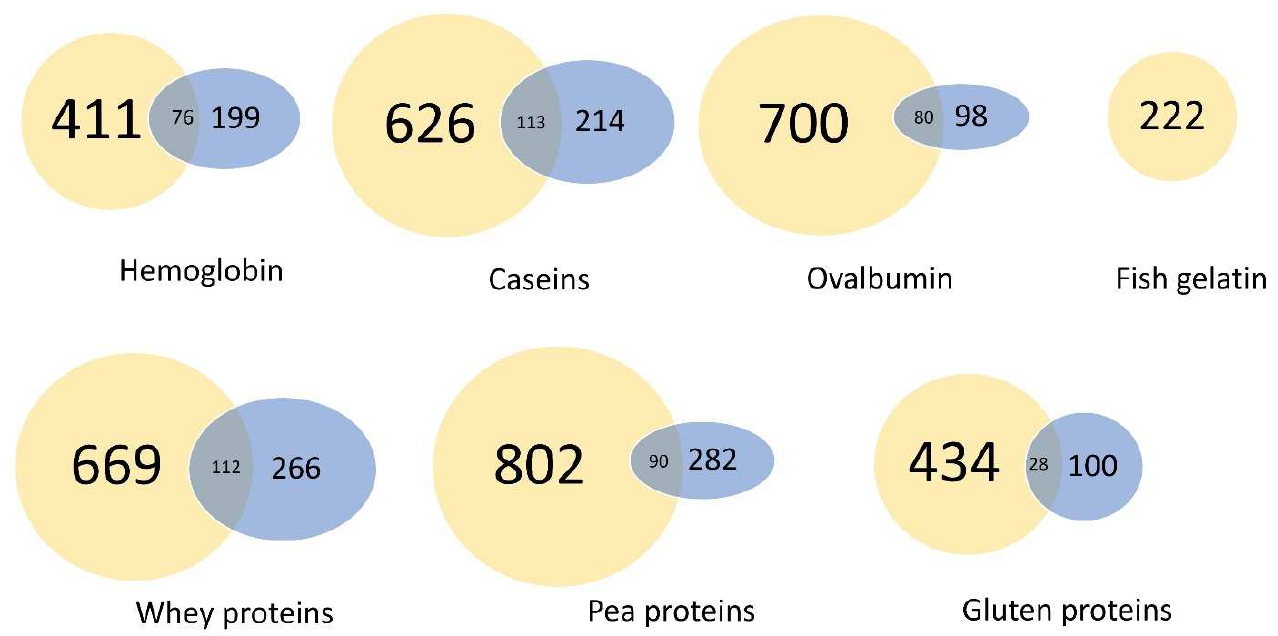
Figure 6. Peptides released during the digestion of dietary proteins can cross the IB in vitro. Peptide distribution in the Caco-2/HT29-MTX cocultured IB model after 1.5 h incubation with digested dietary proteins (31.25 mg · mL − 1 ). The number of different peptides identified (de novo included) at the apical (yellow), basolateral (blue), and both sides (grey) are indicated for each digested